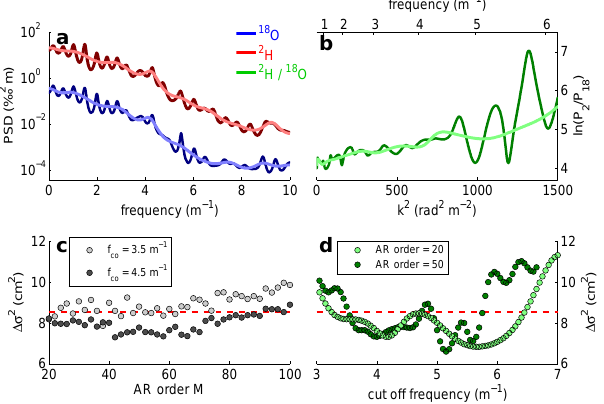
Figure 3. Figure a shows the power spectral densities of the δ 18 O and δ 2 H signals of a synthetic data set. The dark colours in ( a ), ( b ) and ( d ) refer to PSDs calculated with MEM technique with order M = 20. The light colours in these figures correspond to PSDs cal- culated with order 50. In (b) the natural logarithm of the ratio of the PSDs is given as a function of squared wave number. ( c ) and ( d ) show the obtained values for the differential diffusion length as a function of the order of AR and cut-off frequency, respectively. The red dashed lines in these figures indicate the true value of (cid:49)σ 2 for this data set.